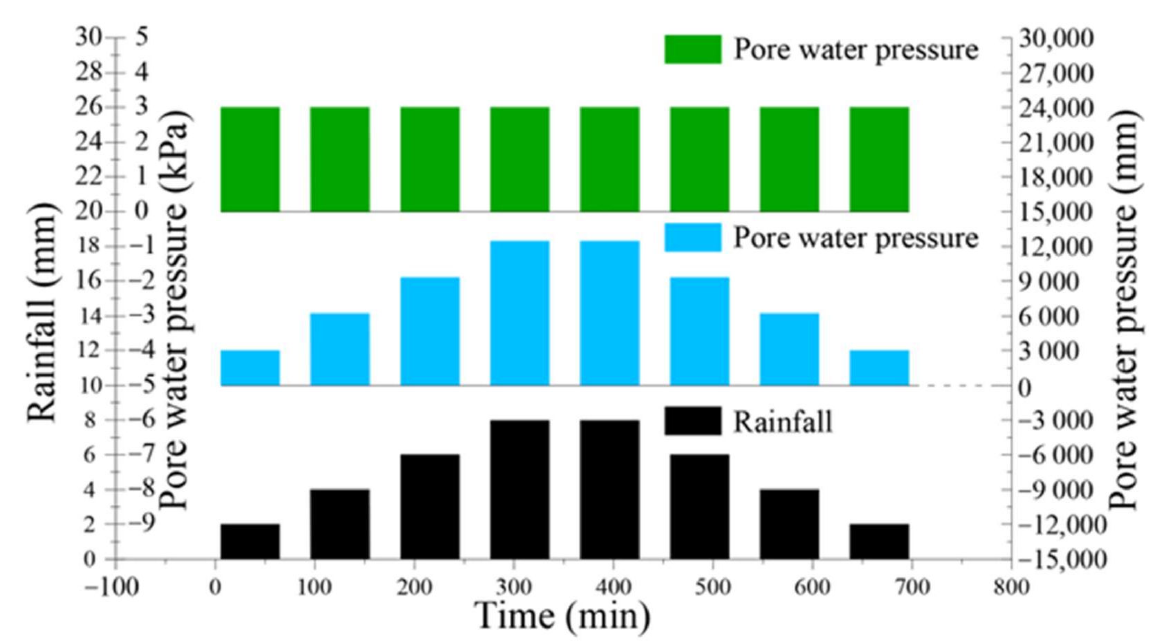
Figure 9. Intermittent rainfall test